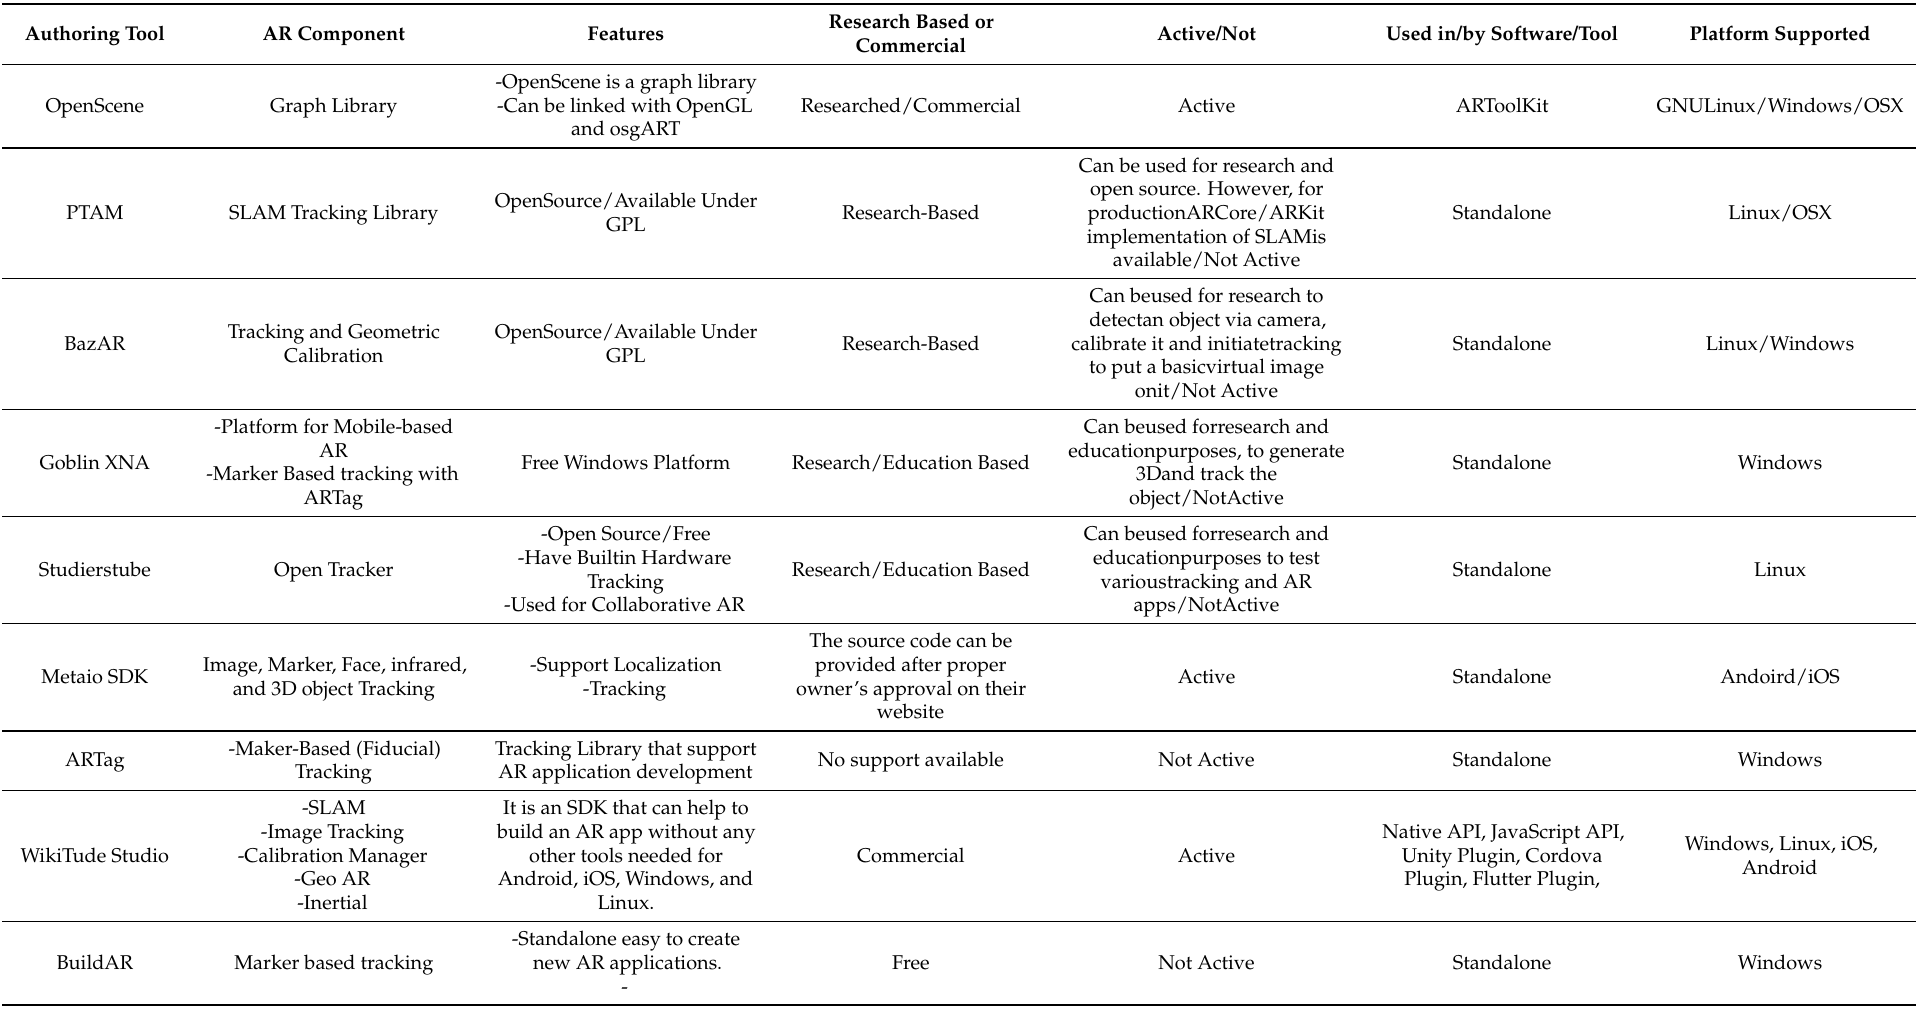
Table 3. A summary of development and authoring tools for augmented reality application